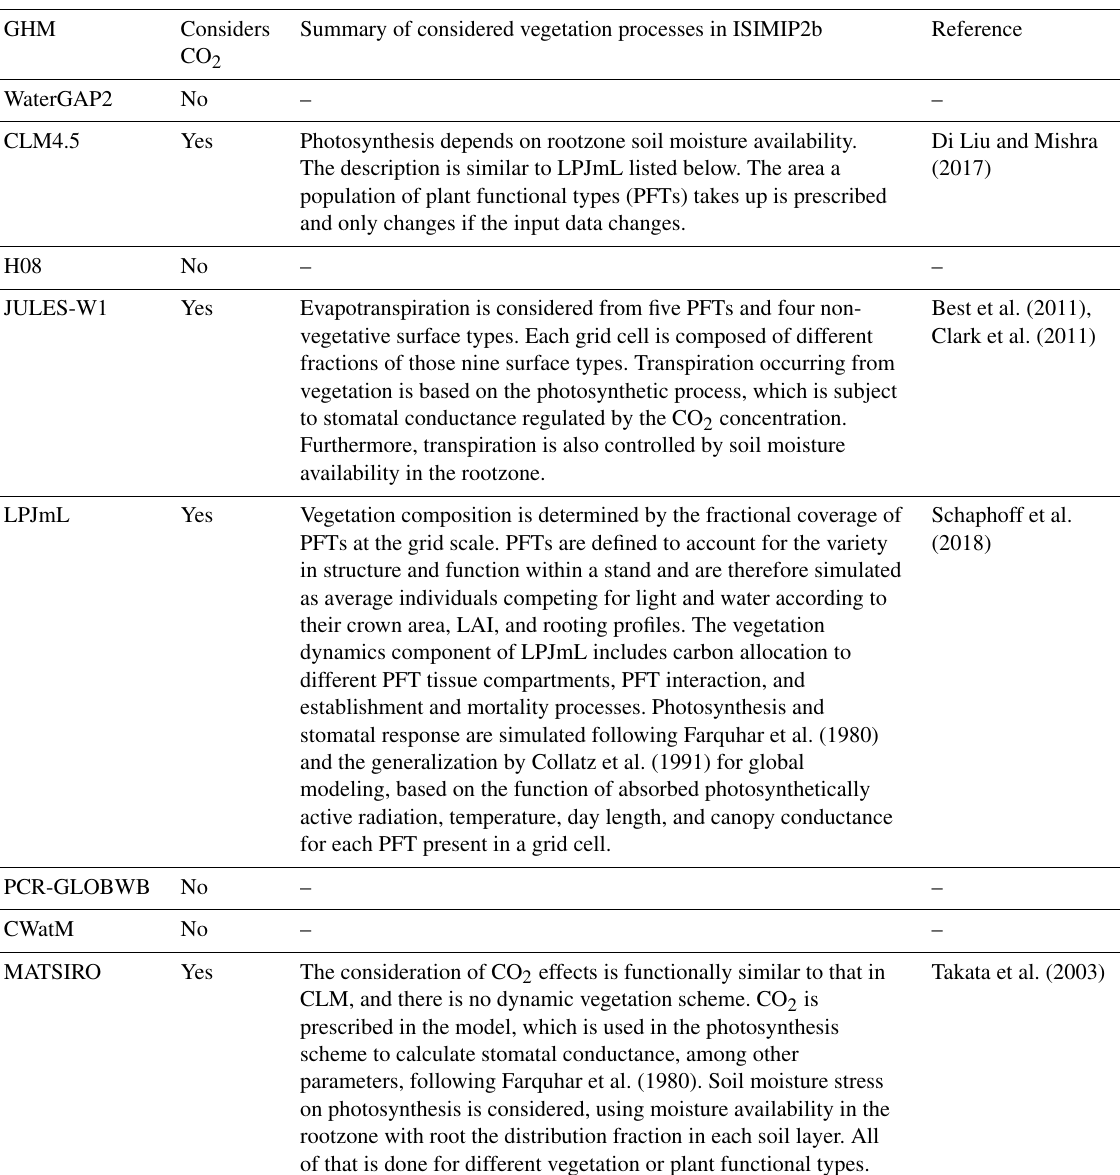
Table 1. Overview of which models are able to simulate the impact of evolving CO 2 concentrations on vegetation and how it is implemented. GHM Considers Summary of considered vegetation processes in ISIMIP2b Reference CO 2